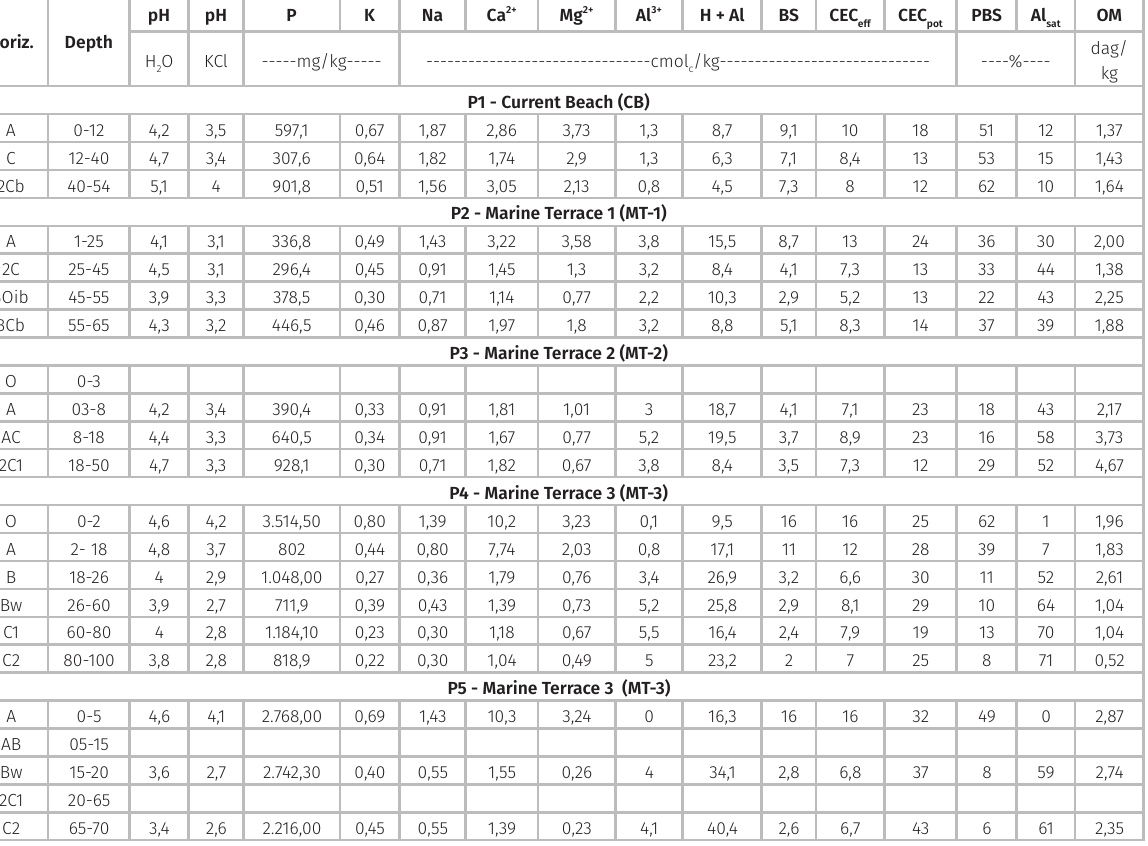
Table II. Chemical properties of soils from HP marine terraces.